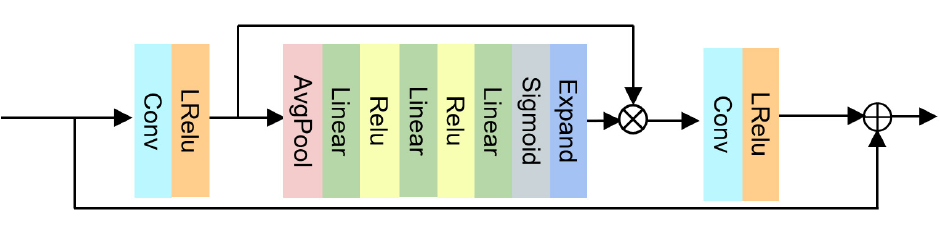
Figure 4. The architecture of